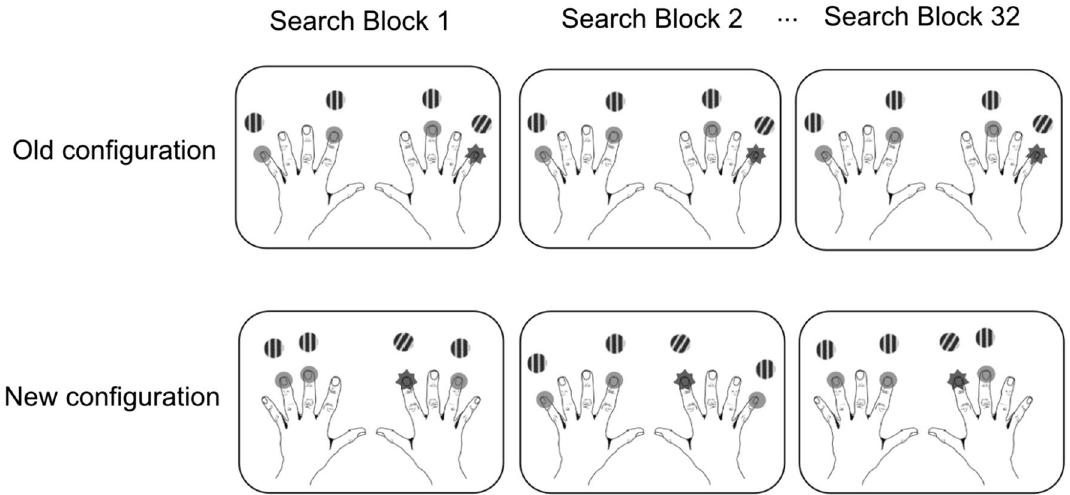
Figure 3. Schematic illustration of the distribution of targets in old and new configurations across search blocks. In old configurations, the target location was constant and paired with constant distractor locations; in new configurations, by contrast, only the target, but not the distractor, locations were held constant across